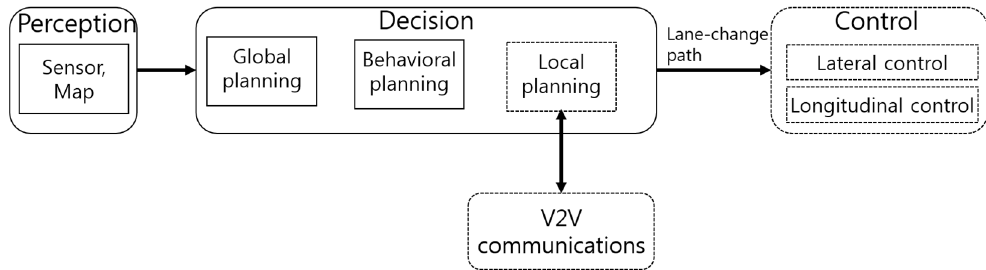
Figure 1. Architecture for a connected and autonomous vehicle (CAV).